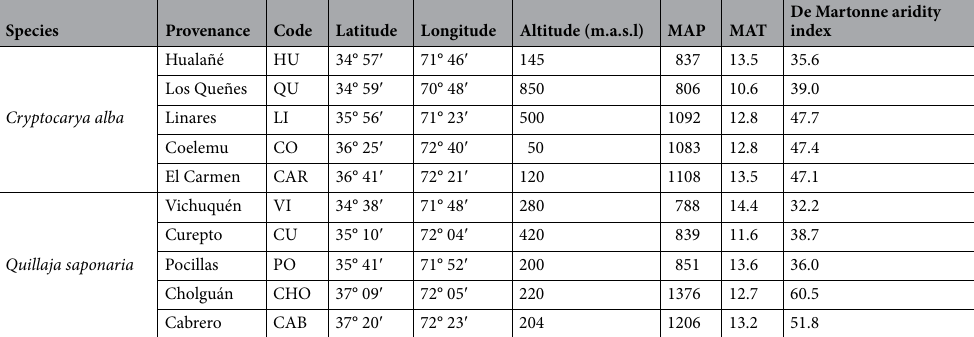
Table 1. Location and climatic parameters for the Q . saponaria and C . alba provenances under study. MAP mean annual precipitation (mm), MAT mean annual temperature (°C). The De Martonne aridity index was estimated as MAP/(MAT +